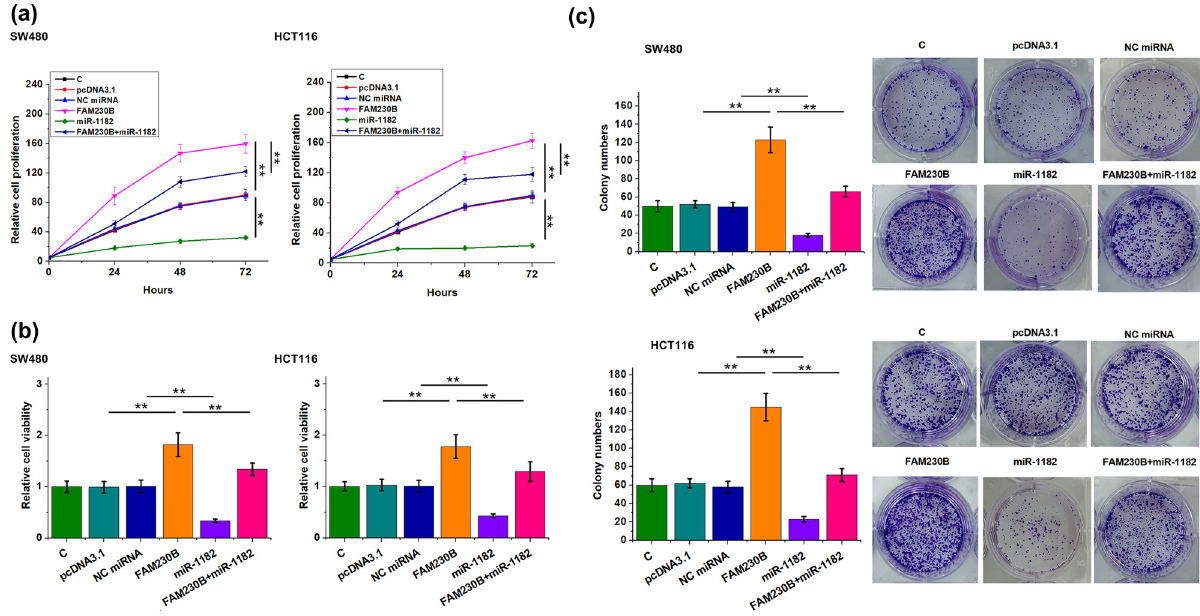
Figure 4: The role of FAM230B and miR - 1182 in the proliferation of CRC cells. The role of FAM230B and miR - 1182 in the proliferation, viability, and colony formation of SW480 and HCT116 cells was analyzed by BrdU assay ( a ) , MTT assay ( b ) , and colony formation assay ( c ) , respectively. ** p <